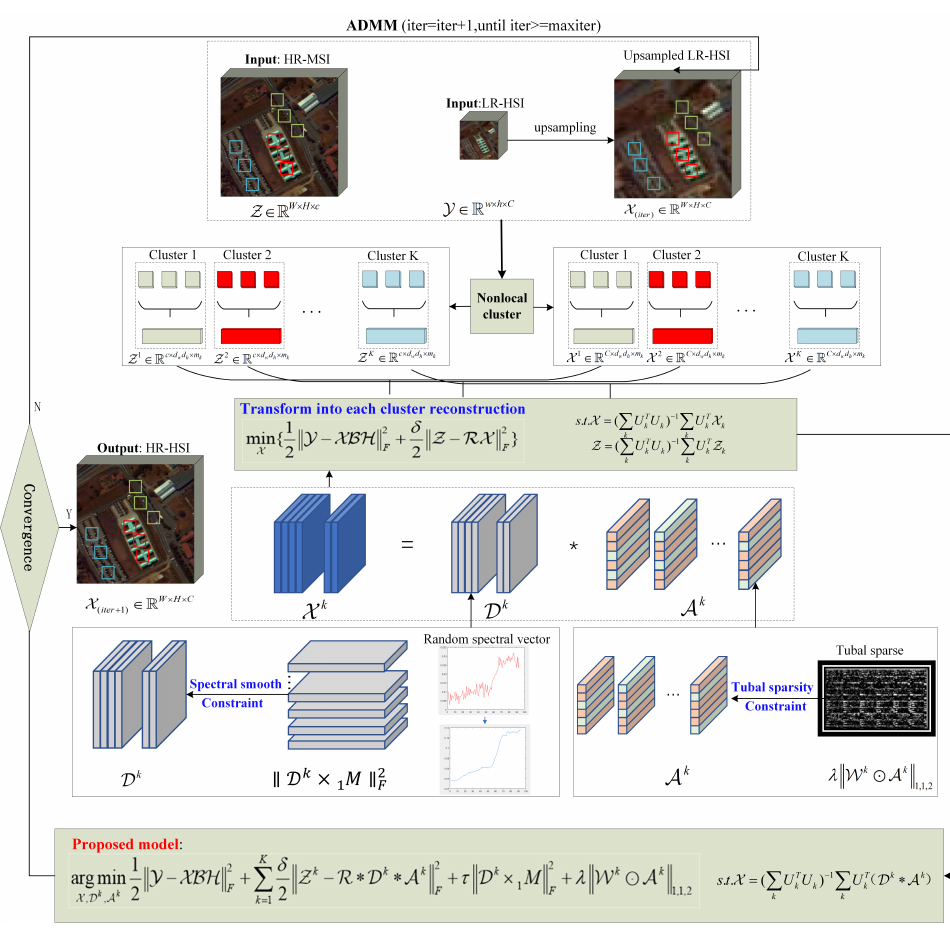
Figure 2. Flowchart of SSTSR